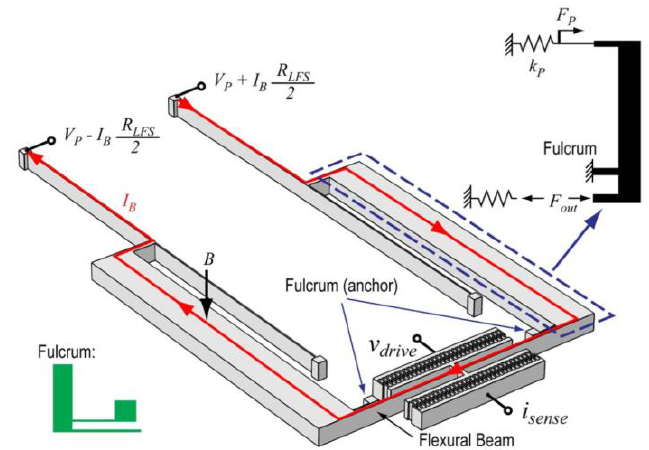
Figure 16. Operation principle of a magnetic field sensor with microleverage mechanism. A magnetic field ( B ) interacts with the DC excitation current ( I B ) to generate a Lorentz force, which operates as axial load on the flexural beam resonator. This force is mechanically amplified by the microleverage mechanism [30]. Reprinted with permission from [30]. Copyright© 2015, IEEE.